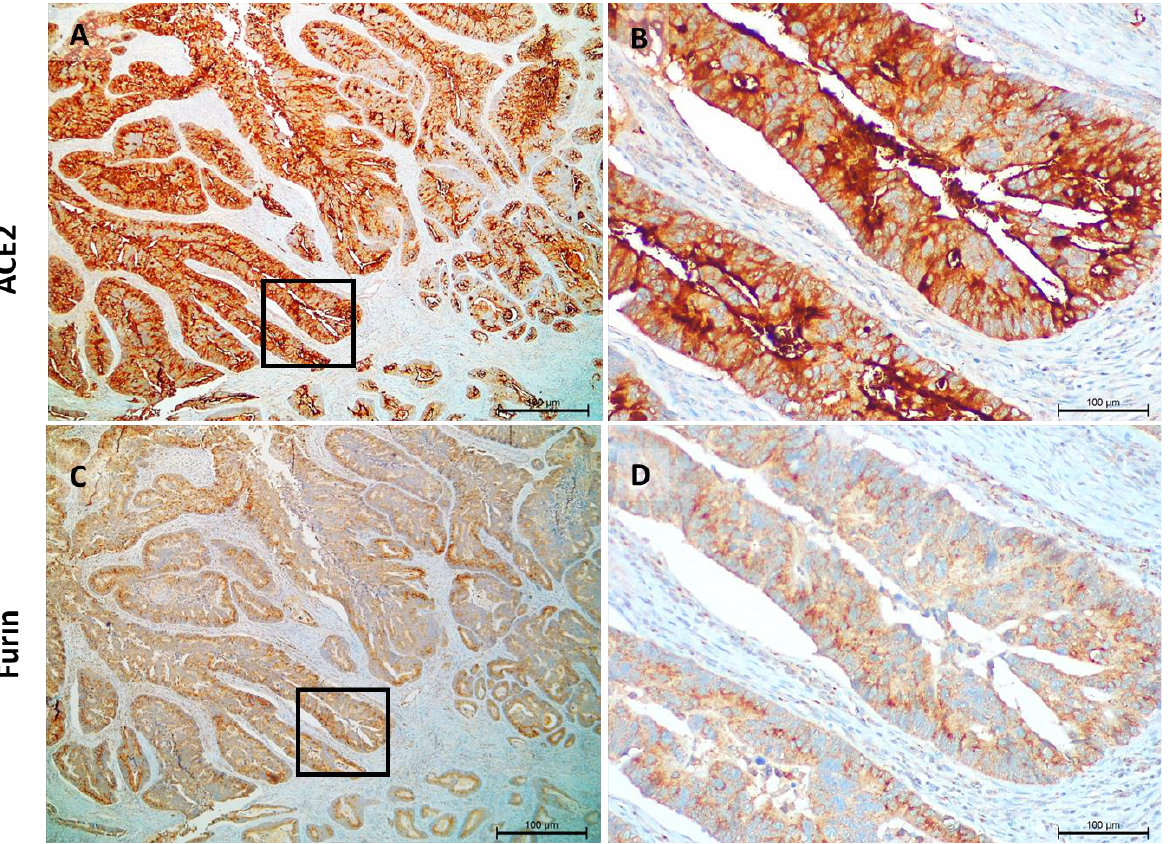
Figure 2. Pattern of expression of ACE2 and furin in colon carcinomas. ACE2 staining is located in the cytoplasm and cell membrane; the intensity is very strong and observed in all colon cancer cells, ( A ) and ( B ). Furin staining is located in the cytoplasm in a granular pattern; the intensity is moderate to strong and is observed in all colon cancer cells, ( C ) and ( D ).